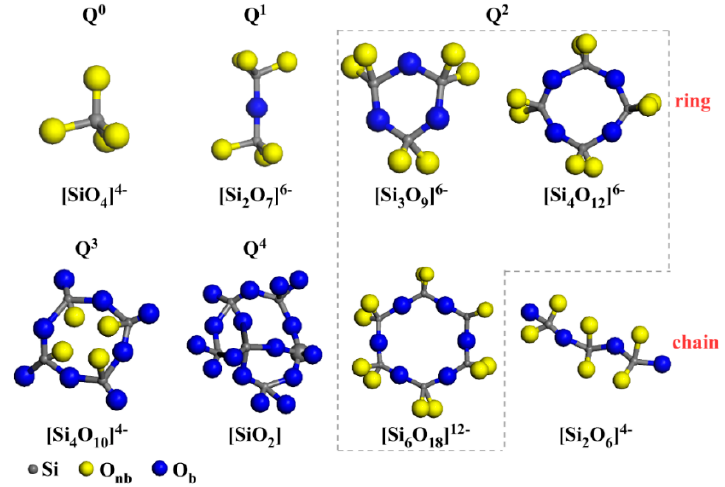
Figure 8. The correlation between Qn and basic silicate structural units.